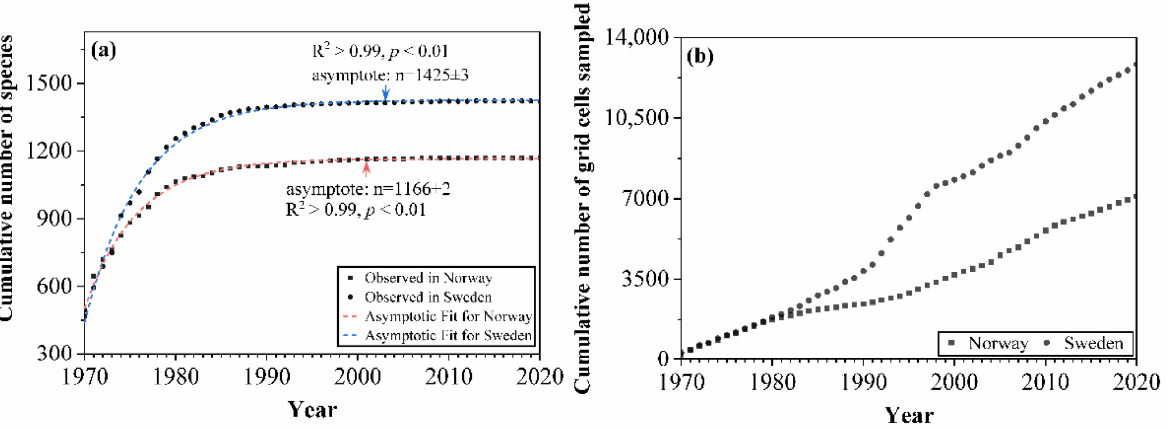
Figure 3. The cumulative number of ( a ) macrofungal species and ( b ) grid cells sampled (i.e., grid cell number with species occurrence inside) used in the model between 1970 and 2020 in Norway and Sweden.